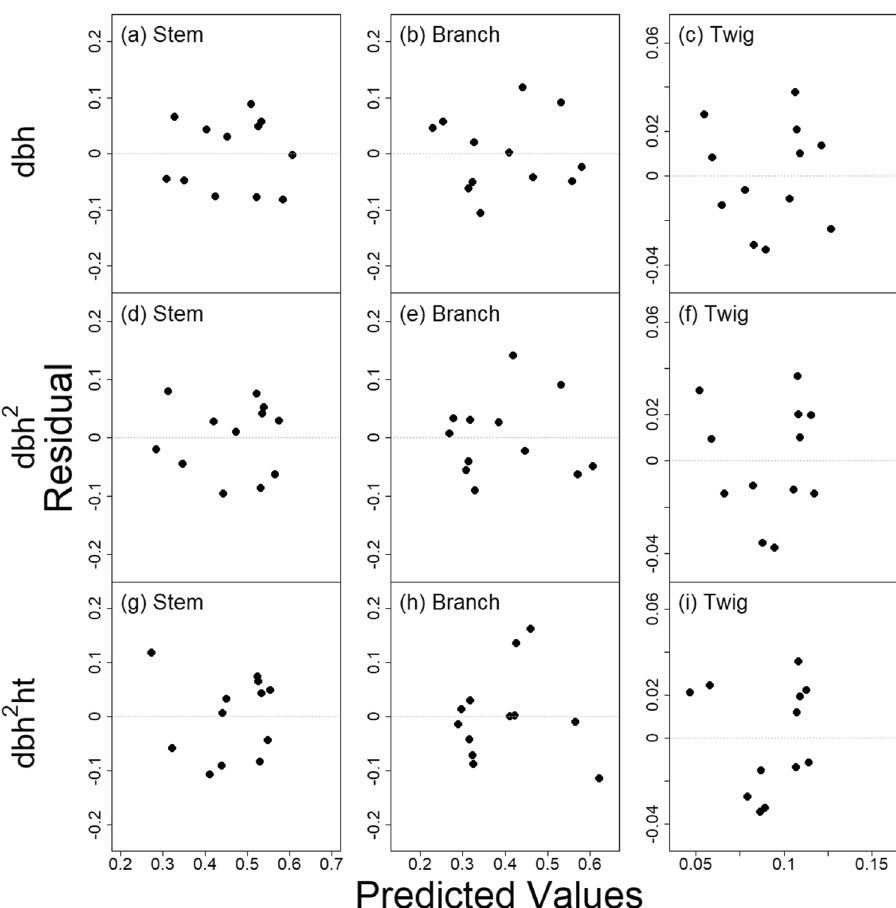
Figure 2. Residuals vs. predicted values of three Linear Seemingly Unrelated Regression models (Eq. 2). The three predictors are: (a–c) dbh, (d–f) dbh 2 , and (g–i) dbh 2 ·ht. Each LSUR model consists of three component ratio models (CRM) for the three biomass components: (a,d,g) main stem, (b,e,h) large branch, and (c,f,i) twig.